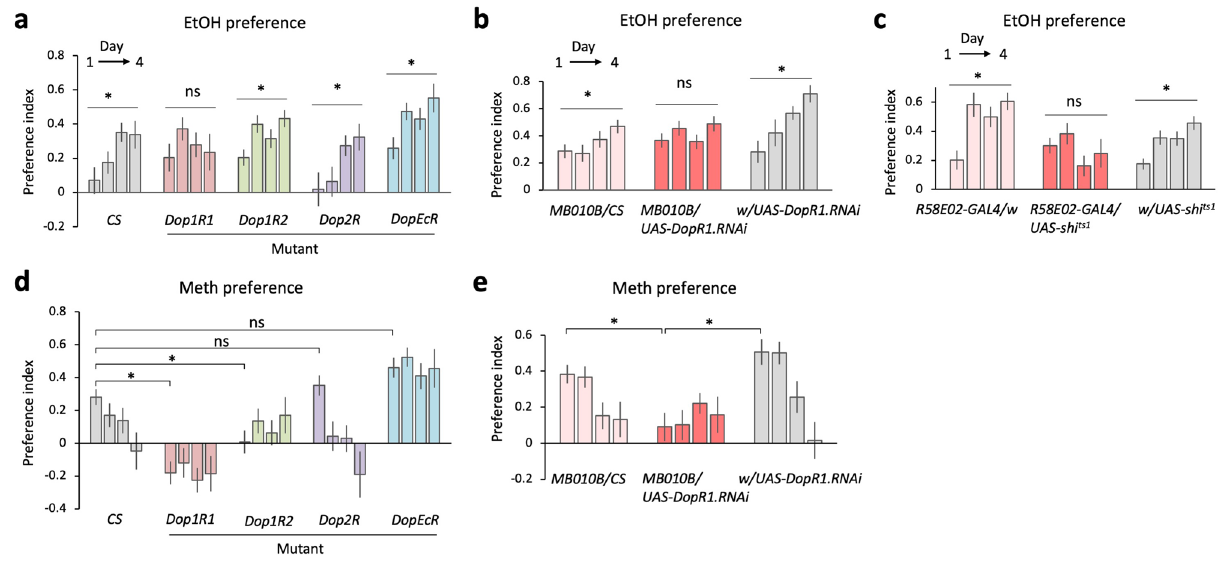
Figure 4. Dop1R1 signaling in the mushroom body mediates ethanol and methamphetamine preference. ( a ) Dop1R1 is necessary for acquired ethanol preference. Daily preference for 15% ethanol is plotted for the wild type ( CS ) and mutant strains for the four dopamine receptors. One-way repeated-measures ANOVA or the Friedman test is performed among the indices from the day 1 to 4. CS : P < 0.0001, n = 24 (Friedman); Dop1R1 : P = 0.2004, n = 22, (Friedman); Dop1R2 : F (2.176, 43.52) = 6.715, P = 0.0023, n = 21 (ANOVA); Dop2R : F (1.676, 38.55) = 5.037, P = 0.0155, n = 24 (ANOVA); DopEcR : F (2.021, 40.42) = 5.731, P = 0.0063, n = 21 (ANOVA). ( b ) Dop1R1 expression in the mushroom body is necessary for acquired ethanol preference. Dop1R1 is